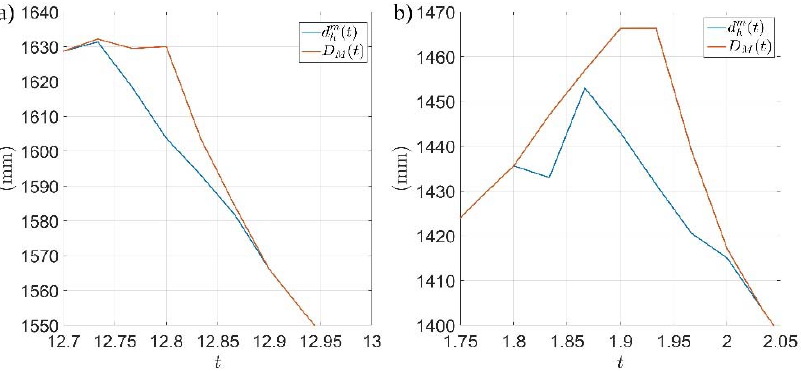
Figure 10. Zoom of the maximum error of the distance probability estimation (DPE) algorithm during the ( a ) one ‐ handed test and ( b ) two ‐ handed test.